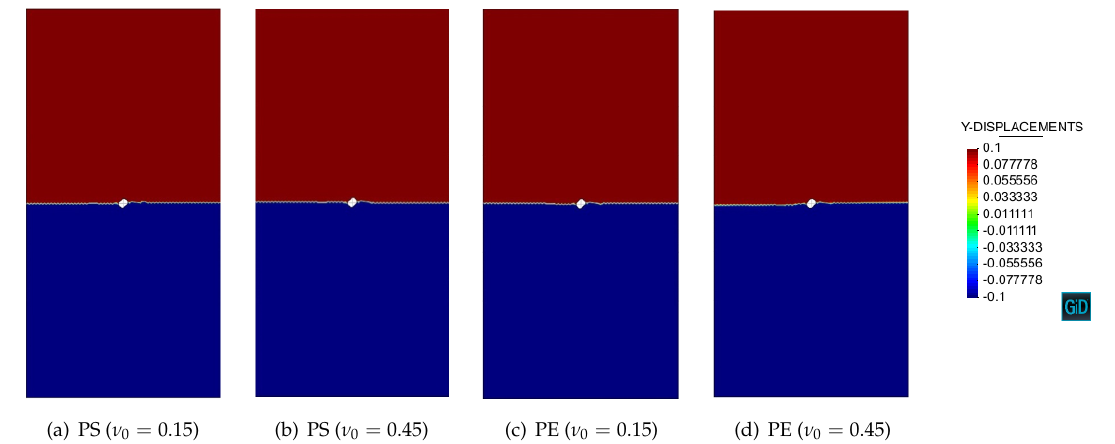
Figure 10. Uniaxial tension of a perforated strip: Modified Simó and Ju damage model in the plane stress (PS) and plane strain (PE)